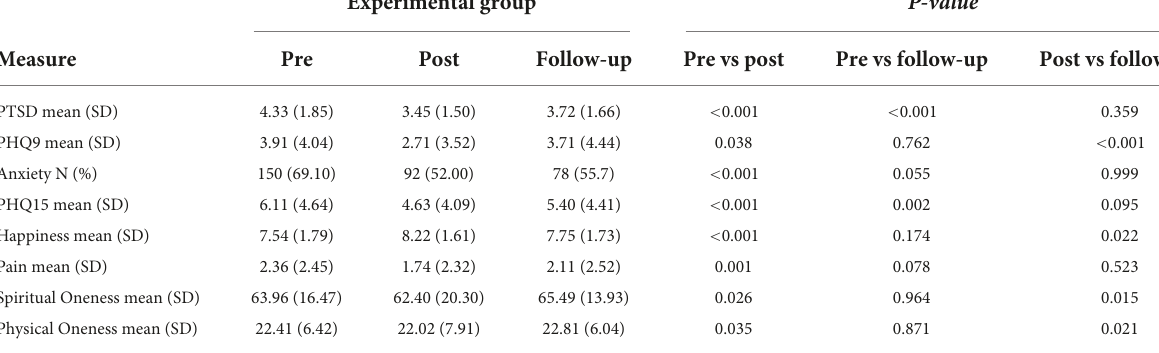
TABLE 3 Experimental group ( n = 140) psychological measures at follow-up compared to pre- and post-test. Experimental group